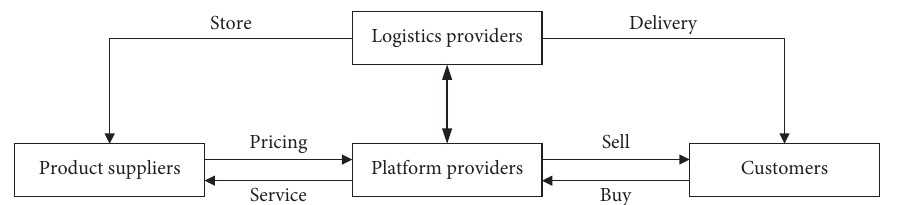
Figure 1: New retail supply chain operation